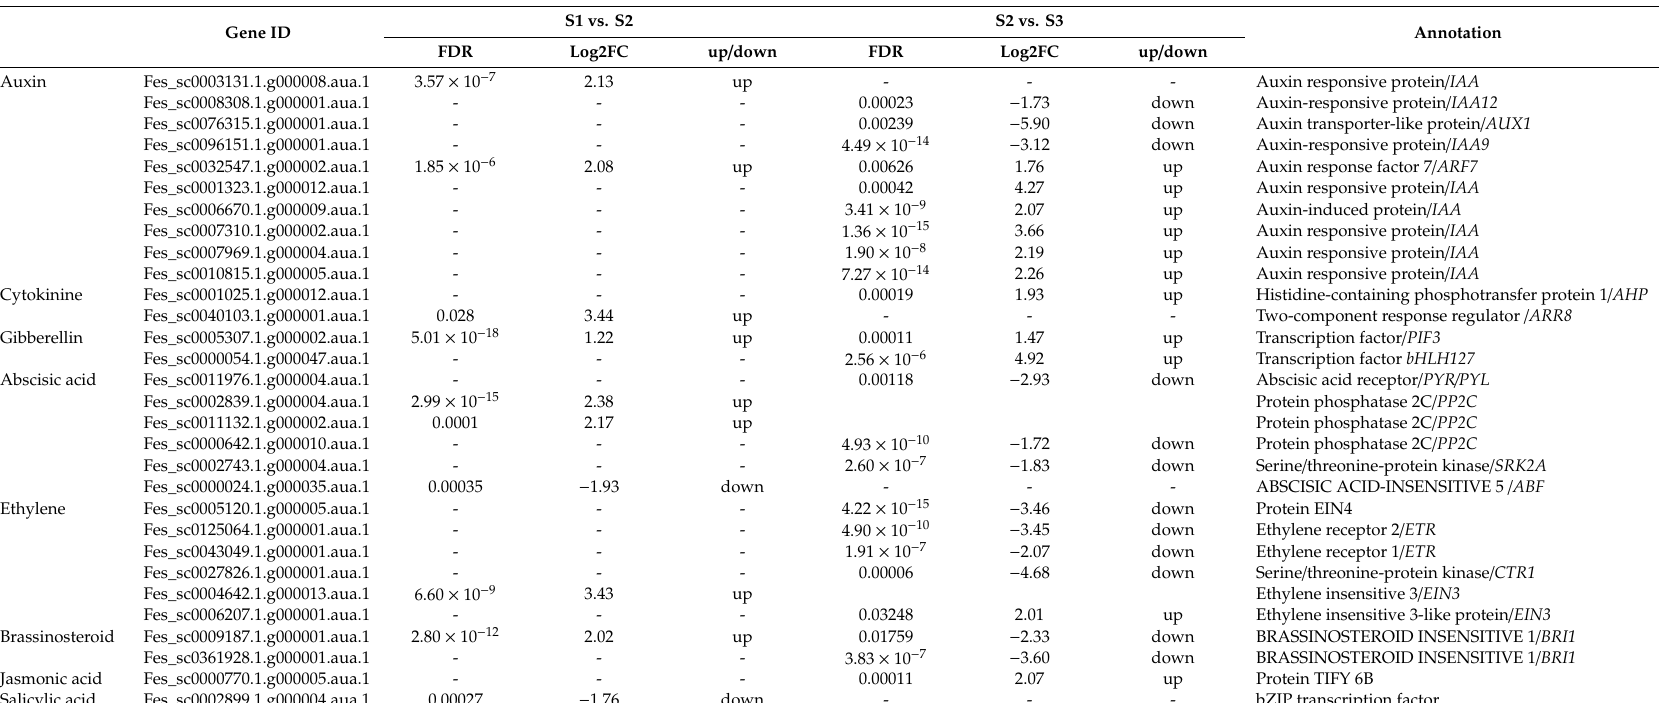
Table 3. DEGs involved in hormone signaling pathways. S1, S2, and S3 stand for the seed samples at pre-filling stage, filling stage, and initial maturity stage, respectively. FDR stands for false discovery rate. Log2FC stand for Log2 fold